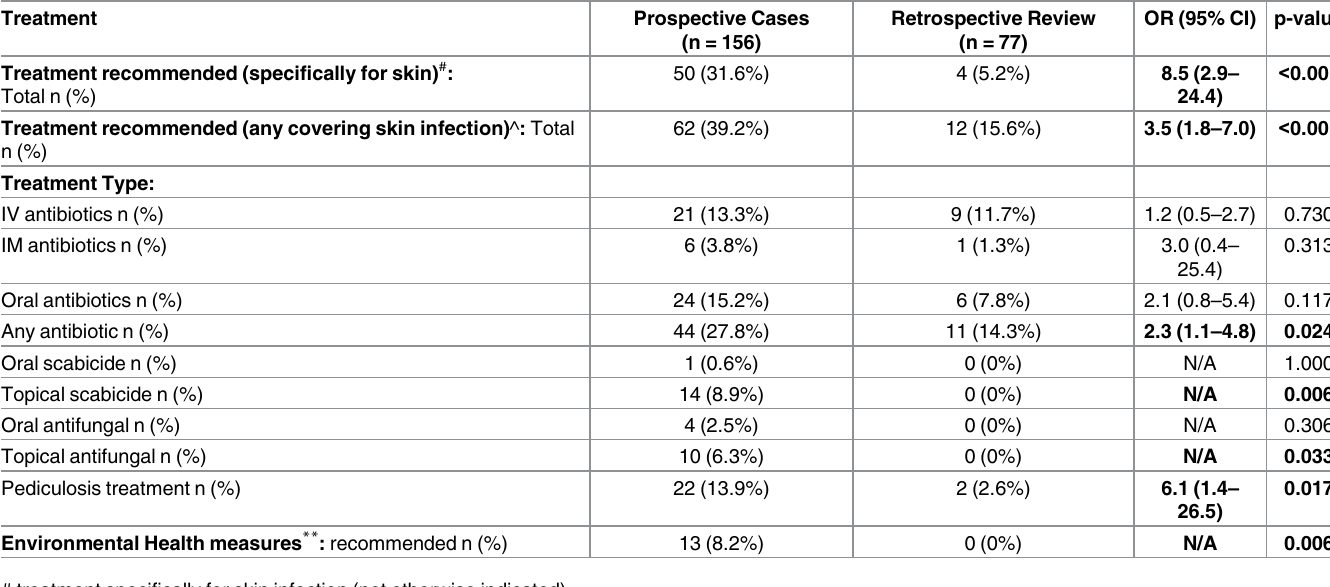
Table 3. Treatment of skin infection prospective vs